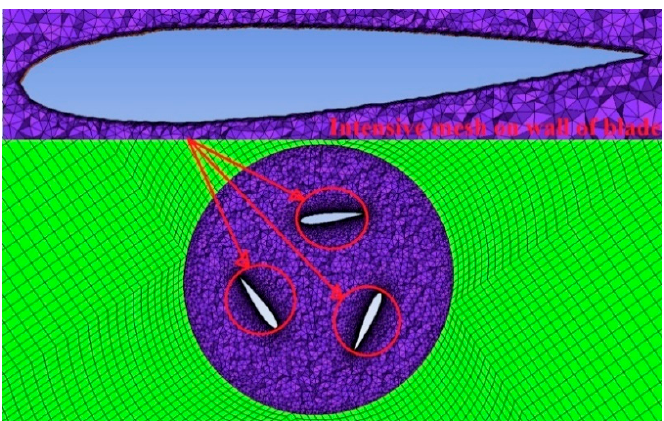
Figure 3. Circular domain and intensive mesh on walls of the blades of NACA 0015 airfoil (using ICEM ANSYS 2019).